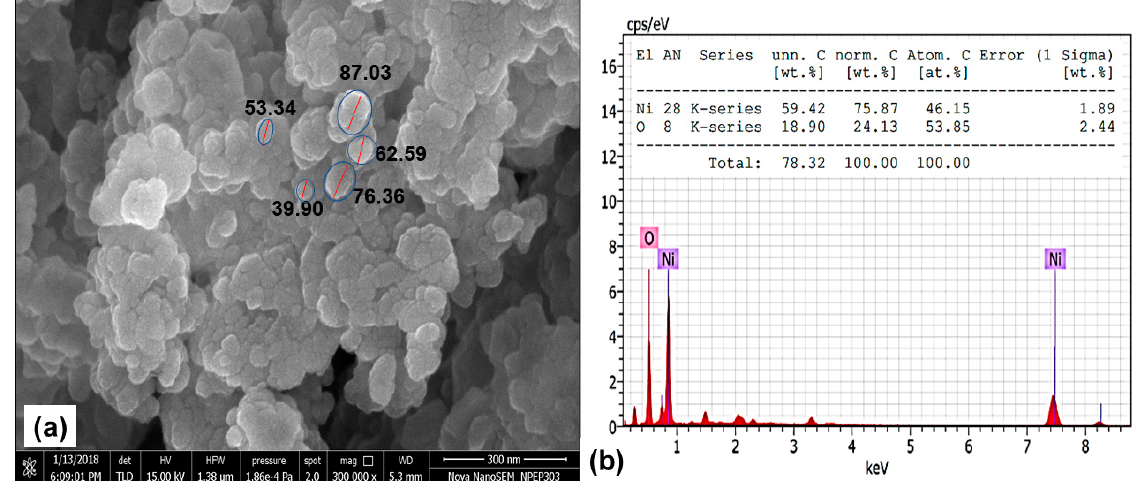
Figure 7. ( a ) SEM image, and ( b ) EDX graph of the biologically fabricated Ni/NiO NPs using leaves extract of Gymnema sylvestre .